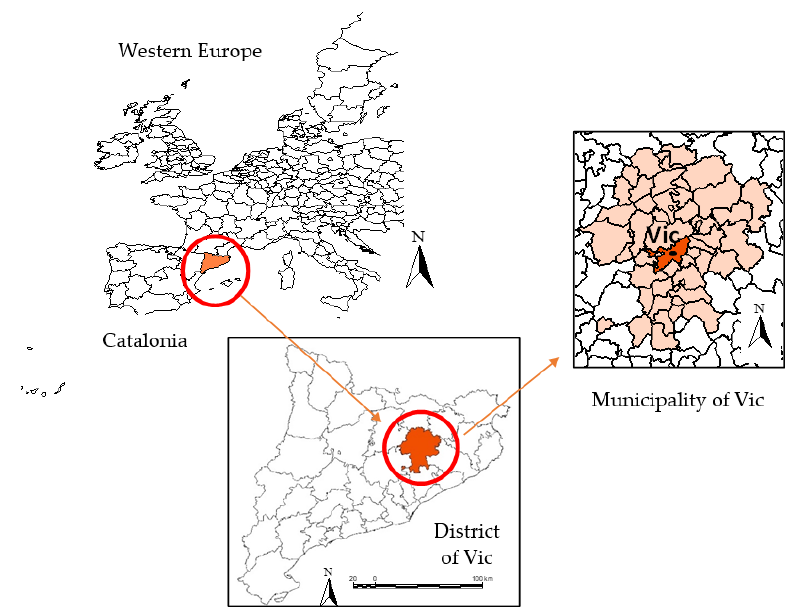
Figure 1. The location of Vic and its pigmeat processing district. Source: Authors’ own elaboration based on [44 – 46].